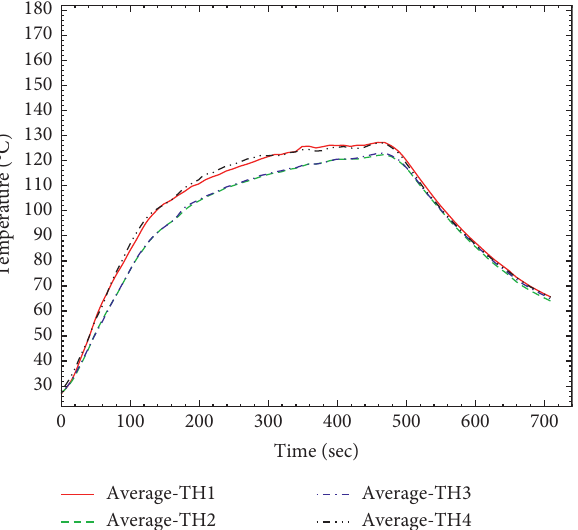
Figure 14: Temperature of hot gases under ceiling of the PFO